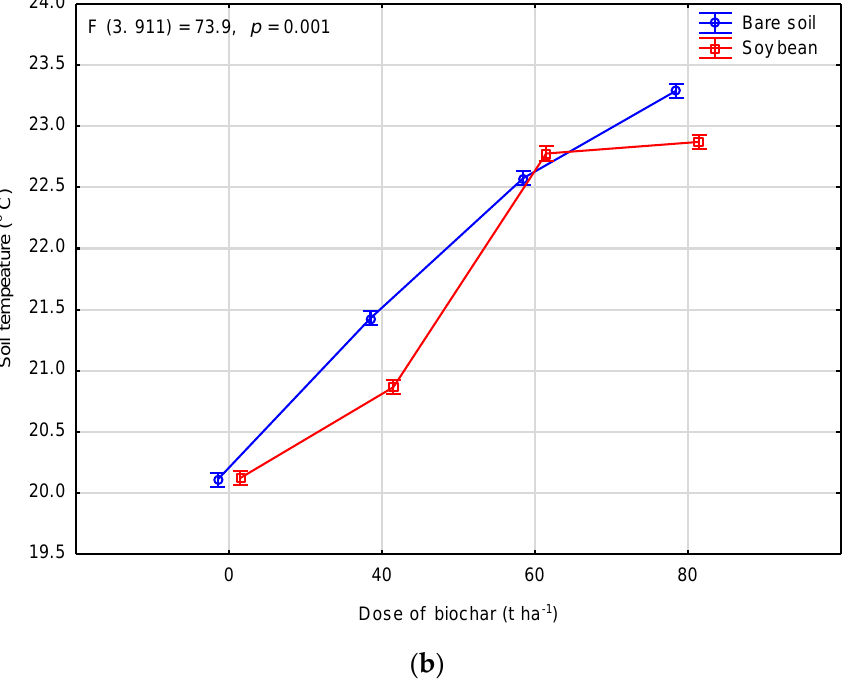
Figure 4. Effect of factor convergence on ( a ) soil respiration and ( b ) soil temperature. Table 4. Soil respiration activity, average soil temperature, and water vapor flow in the soil in the second year after biochar application, depending on the soil protection variant.